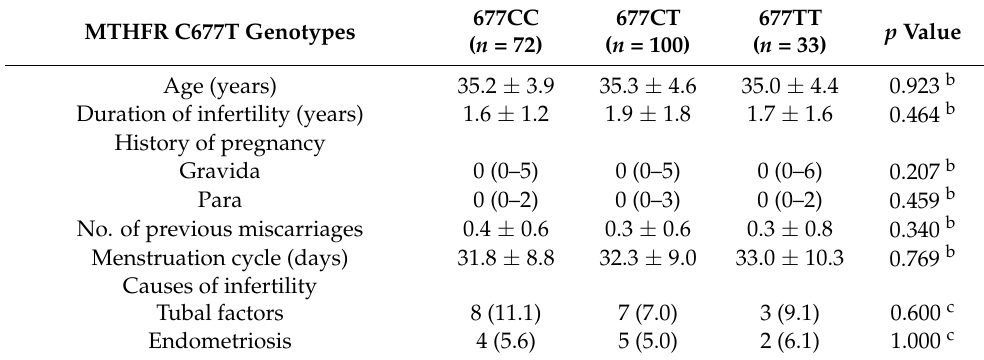
Table 1. Characteristics of infertile